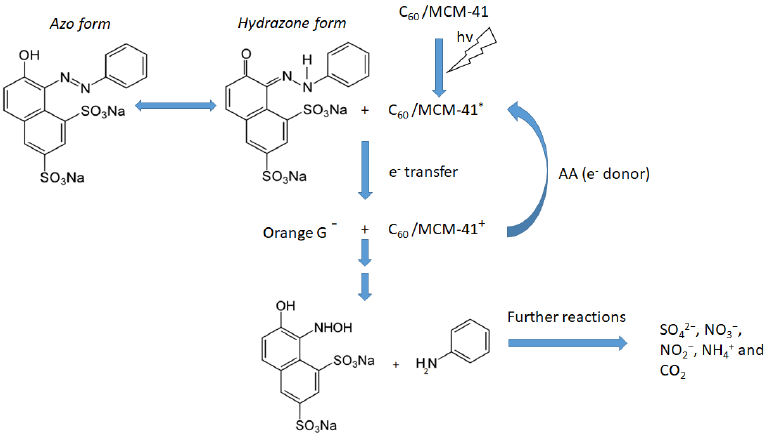
Scheme 1. A schematic representation illustrating the tentative pathway of orange G (OG) degradation over C 60 /MCM-41